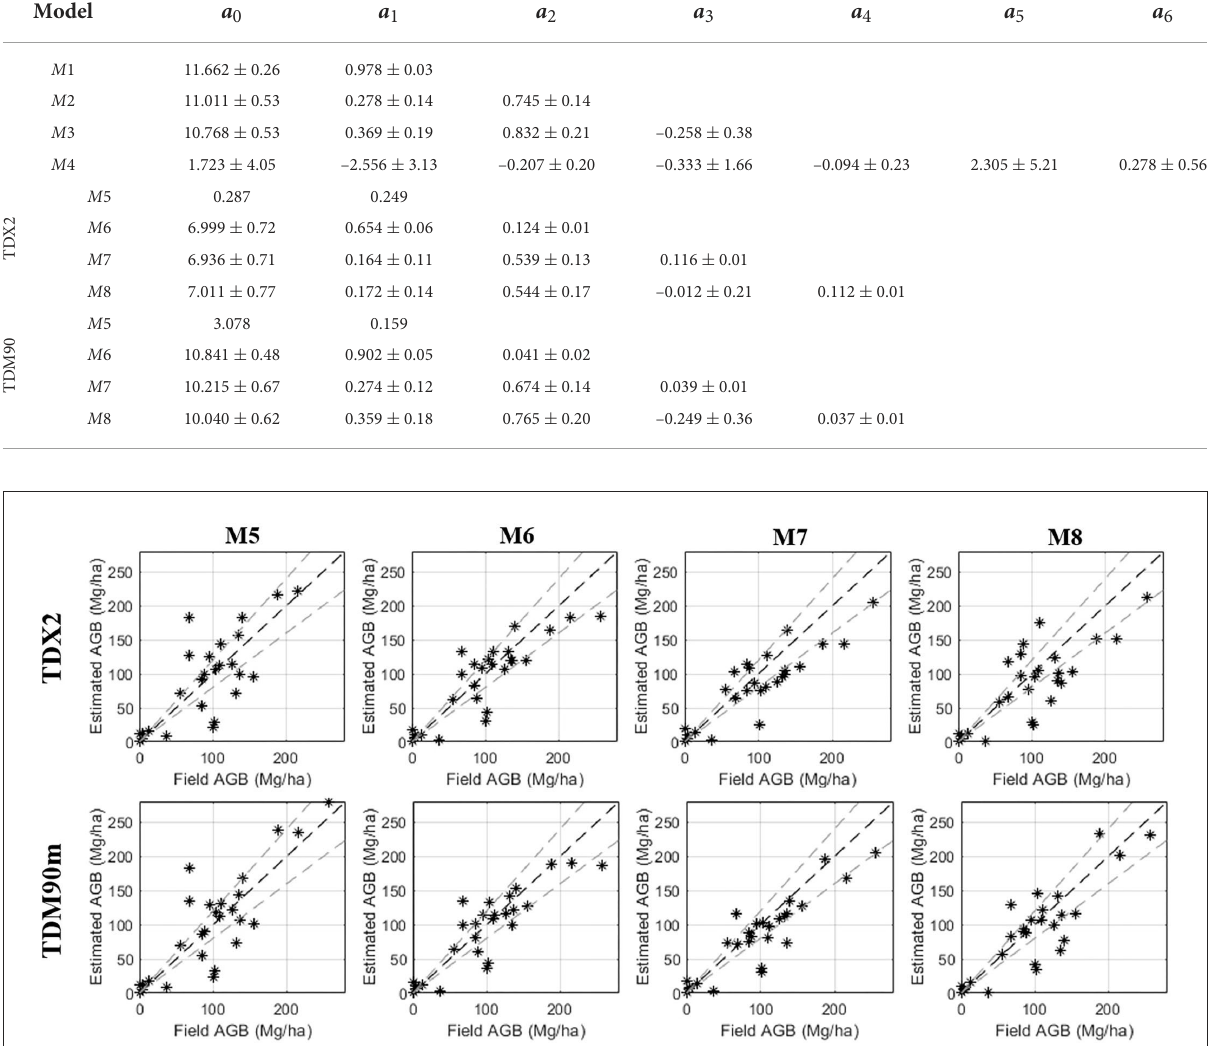
FIGURE9 Comparison of combined models based on backscatter and height. Training and validation carried out using temporally averaged backscatter data. First row represents models with TDX2 PolInSAR height as input and second row represents models with TDM90m DEM estimated height as